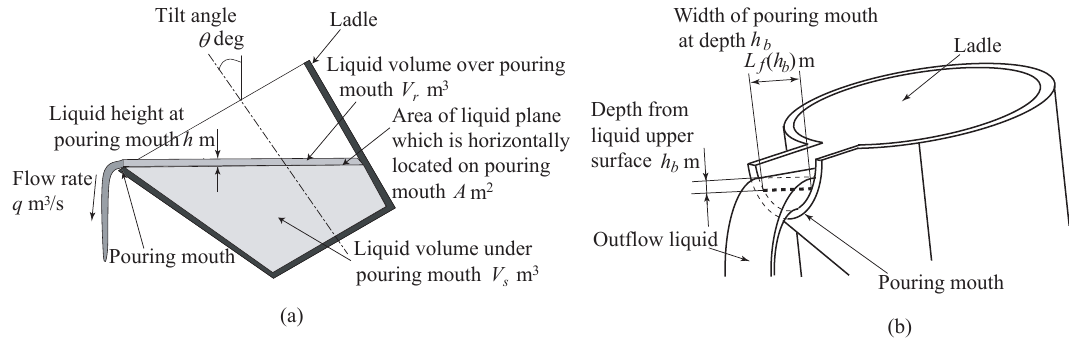
Figure 4. Geometric parameters of pouring process. ( a ) Parameters related to the ladle shape, and ( b ) parameters related to the pouring